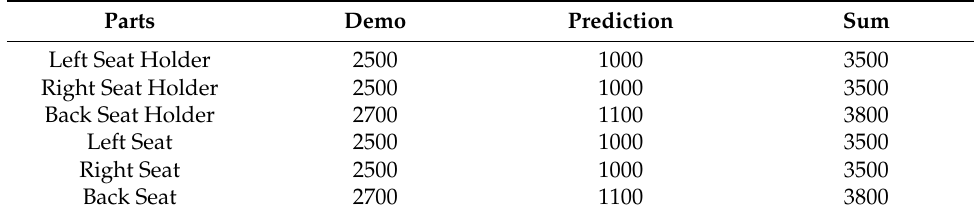
Table 2. The dataset of the tracking process.